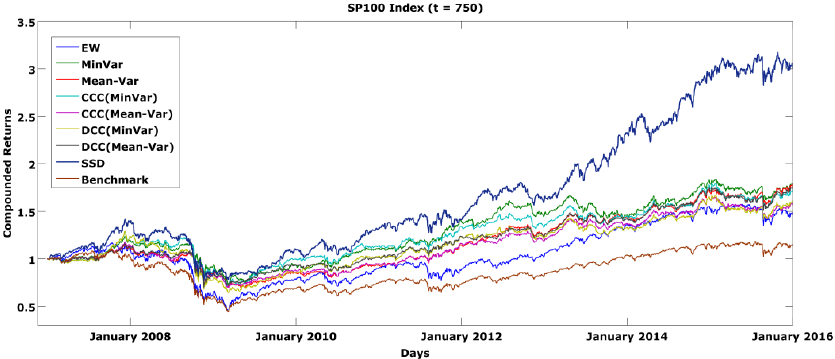
Figure 2. Compounded (on daily basis) returns of portfolios consisting of DJ stocks, t = 1000.